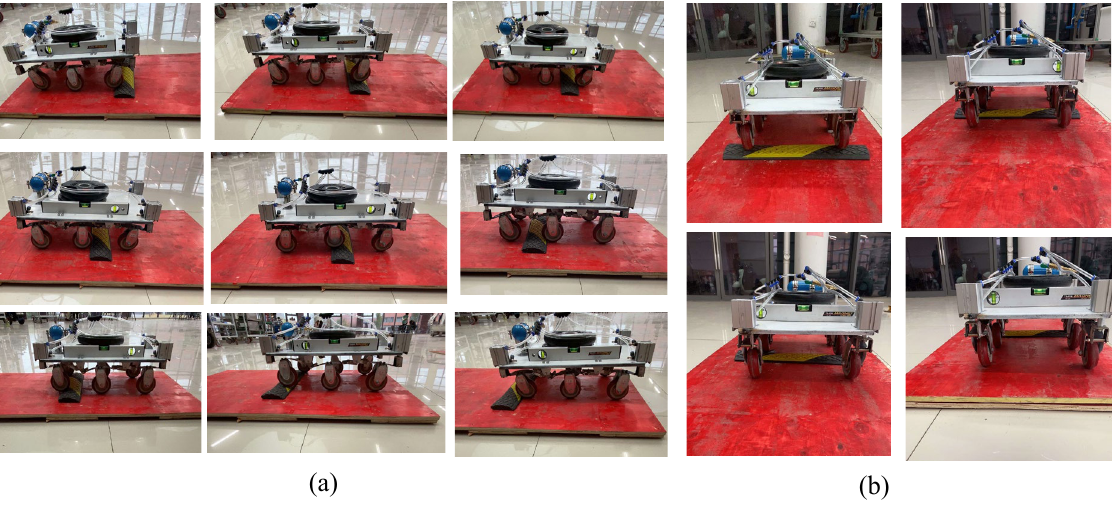
Figure 17. Obstacle crossing test of bilateral bosses in ( a ) longitudinal direction and ( b ) transverse direction.